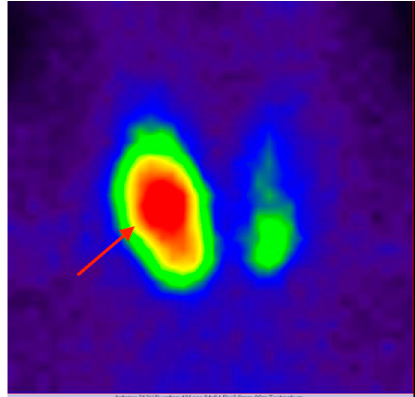
Figure 1. Thyroid scintigraphy with Tc-99m pertechnetate AP incidence showing a hot nodule (red arrow) in the right thyroid lobe, suggestive for thyroid adenoma (GE gamma camera LEHR); final histology exam being a hobnail variant of thyroid papillary microcarcinoma within an adenomatous nodule.